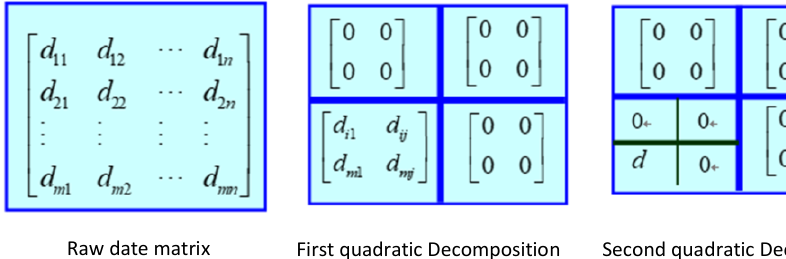
Figure 5. Sketch of SVD of a four-block matrix.